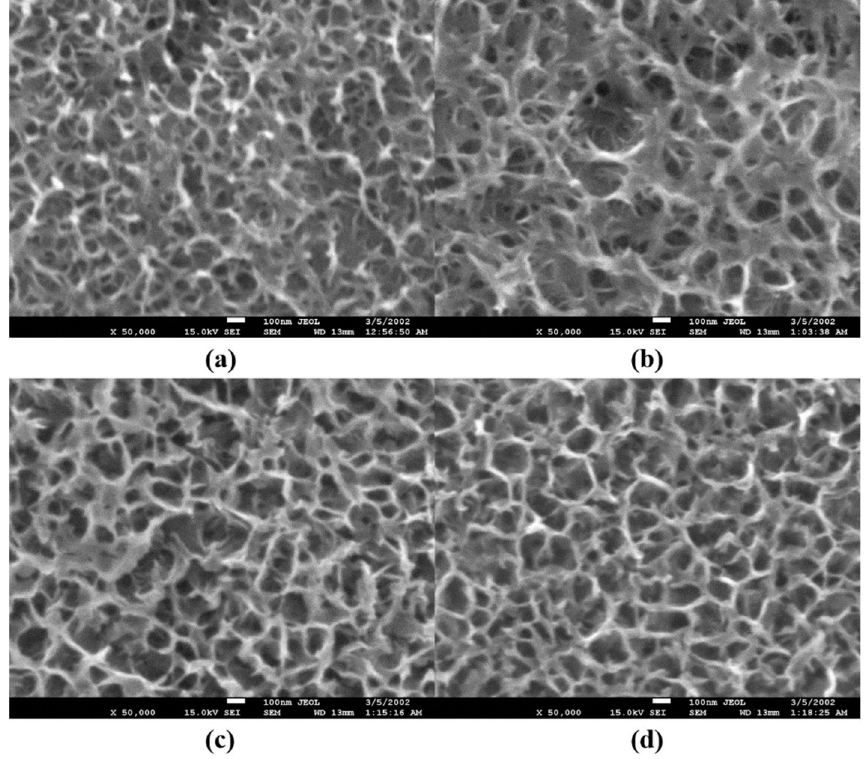
Figure 4. SEM images of TiO 2 electrodes prepared in 4M NaOH for ( a ) 15, ( b ) 60, ( c ) 120, and ( d ) 240 min.